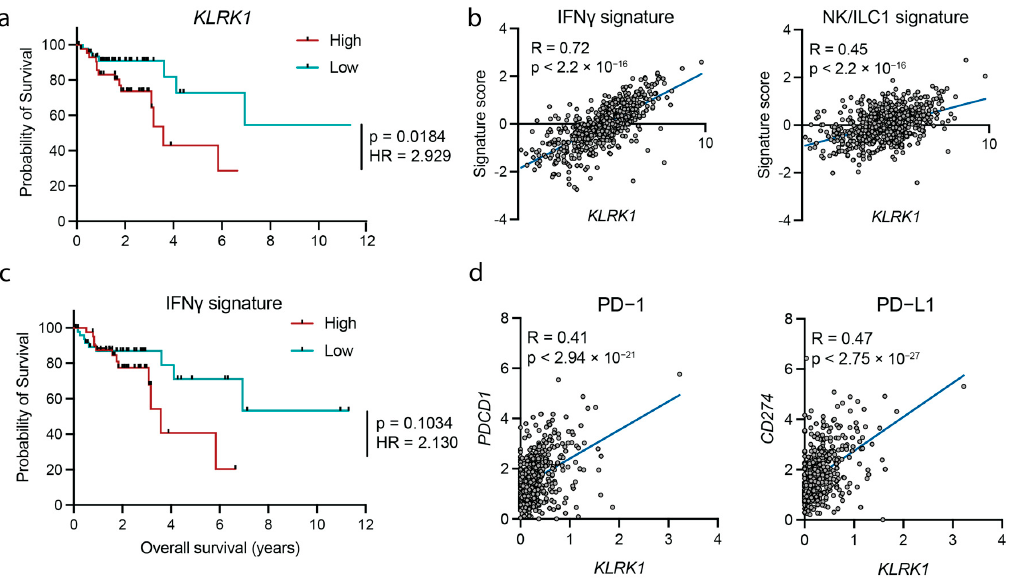
Figure 2. NKG2D expression associates with an IFN γ response and the expression of inhibitory immune checkpoint markers. ( a ) Survival probability in patients expressing high (red) vs. low (teal) levels of KLRK1 . ( b ) Correlation between an IFN γ signature (left) and an NK/ILC1 signature (right) and KLRK1 expression. ( c ) Survival probability in patients with a high (red) vs. low (teal) IFN γ signature. ( d ) Correlation between PD-1 ( PDCD1 ) (left) and PD-L1 ( CD274 ) (right) and KLRK1 in colorectal cancer patients. COAD = Colon Adenocarcinoma, GSEA = gene set enrichment analysis, HR = hazard ratio. Statistical significance was determined using Log-rank (Mantel-Cox) and Mantel- Haezenszel test comparing upper and lower percentile ( a , c ) and linear regression analysis ( b , d ). 3.3. Tumorigenesis in the Apc min/+ Mouse Correlates with Increased NKG2D Expression and